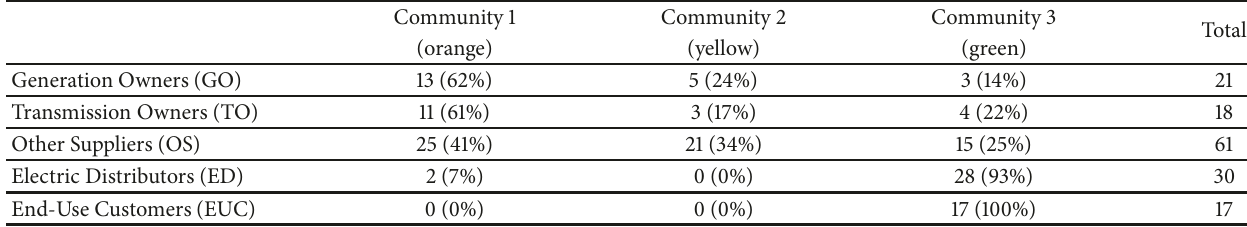
Table 4: The number of voters in the detected communities by industry sectors (no network).